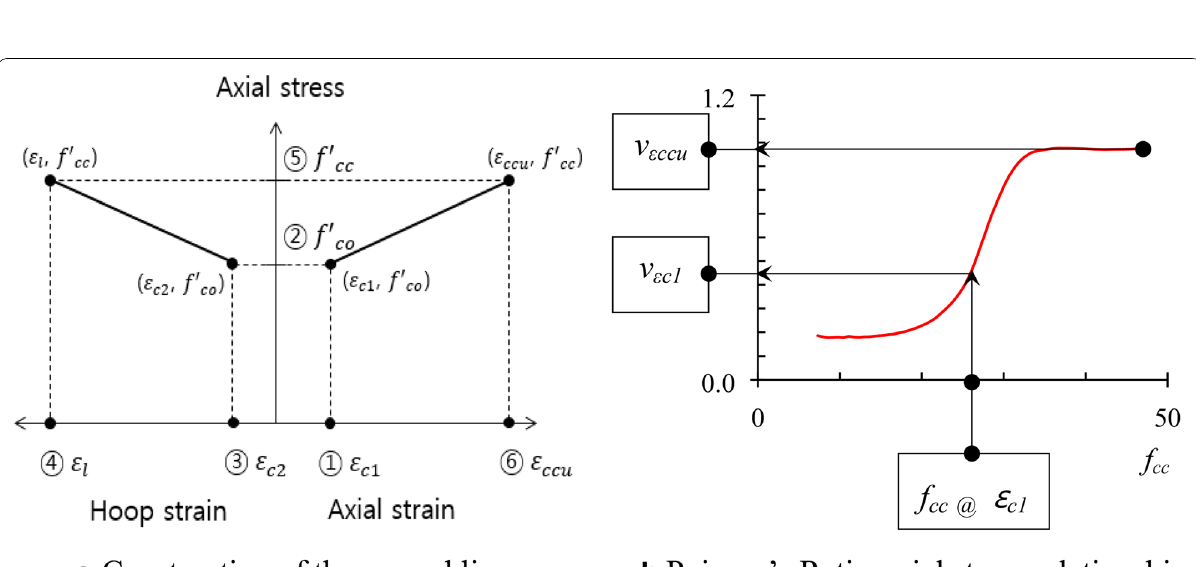
Fig. 11 Construction of simplified stress–strain